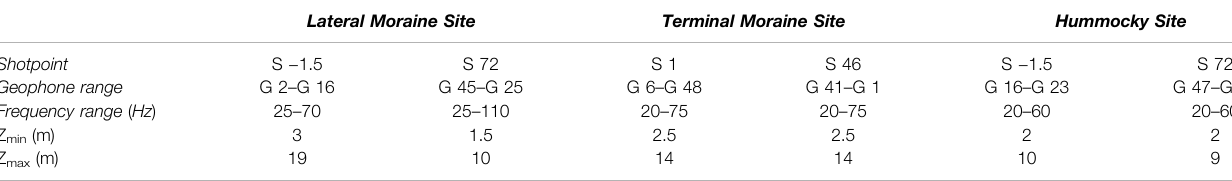
TABLE 1 | MASW dispersion curve inputs and resolutions for the three